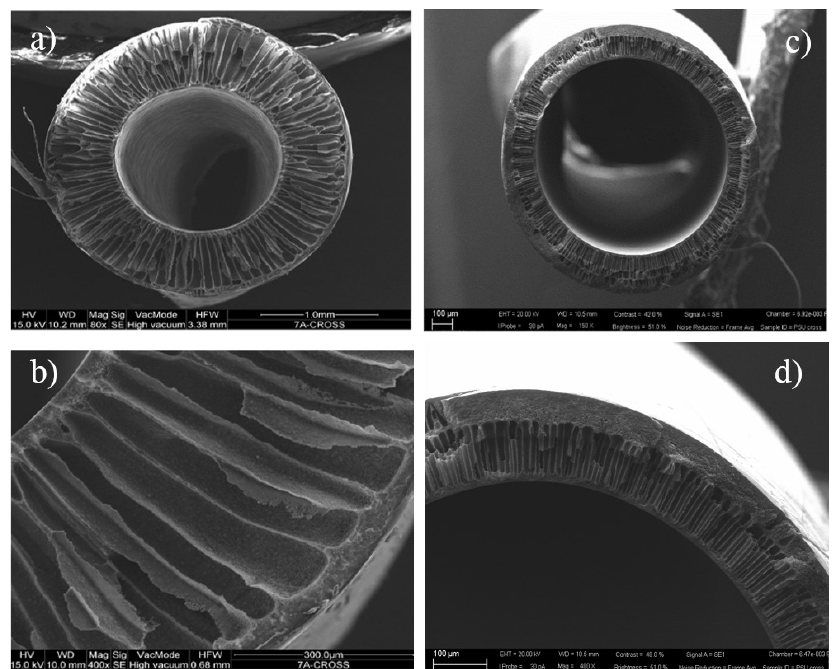
Figure 1. Scanning electron microscopy (SEM) images of the cross-section of polyvinylidene fluoride (PVDF) ( a ) and polysulfone (PSU) ( c ) hollow fiber (HF) membranes with their respective magnifications ( b , d ).